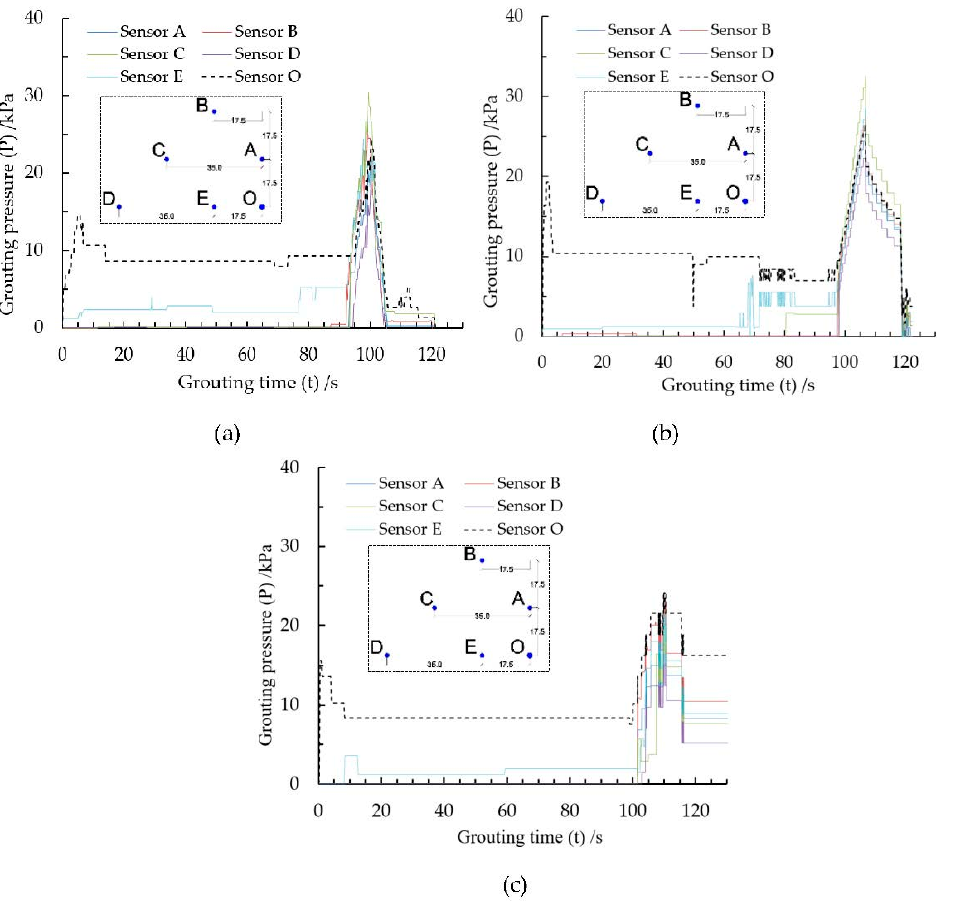
Figure 10. The change in the grouting pressure over time under di ff erent test conditions. ( a ) R1; ( b ) R2; ( c ) R3.